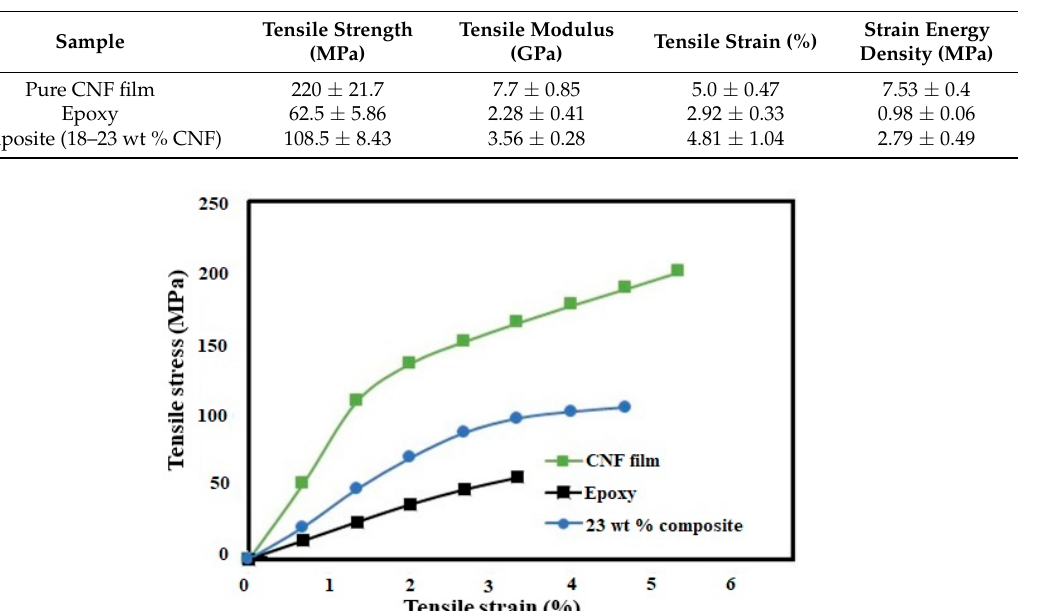
Figure 4. Representative stress-strain curves of the CNF film cured neat epoxy resin, and composite.